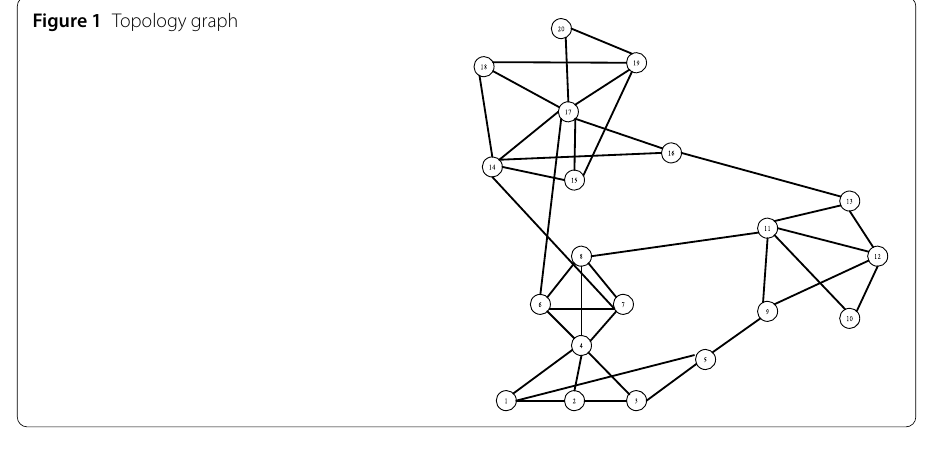
Figure 1 Topology